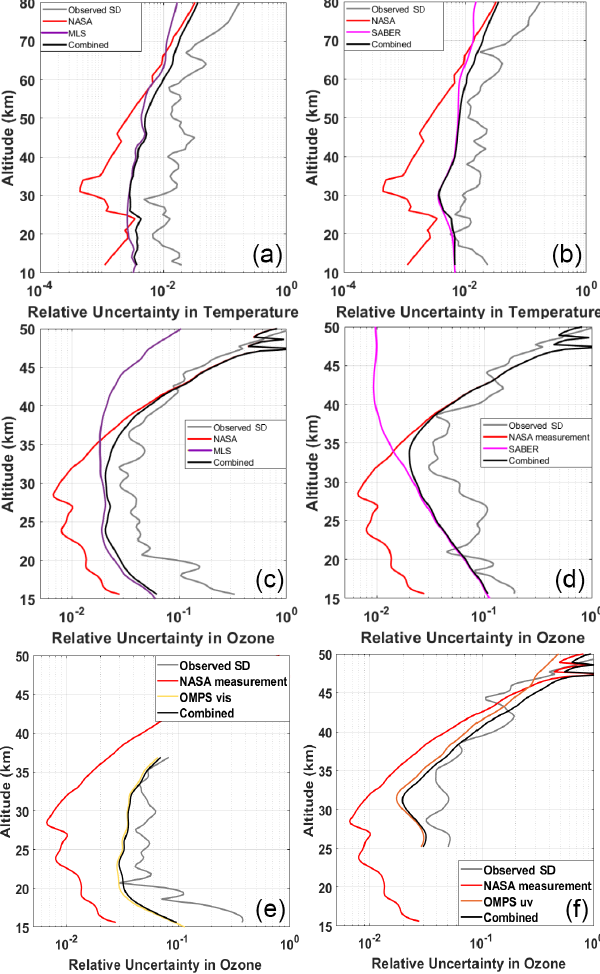
Figure 16. Comparison of relative uncertainties in both temperature and ozone for the NASA lidar (red), MLS (violet), SABER (ma- genta), OMPS visible (mustard), and OMPS UV (burnt orange).